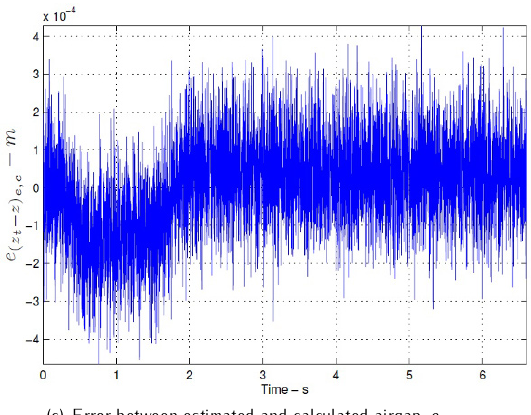
Figure 10. Error between the measured-estimated ( e ( zt−z ) m,e ) , measured-calculated ( e and estimated- ( zt−z ) m,c ) airgap signals. calculated ( e ( zt−z ) e,c )